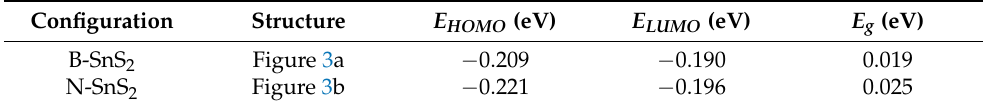
Figure 3. HOMO and LUMO of ( a ) B-SnS 2 and ( b ) N-SnS 2 . Table 1. Energy of HOMO, LUMO, and energy gap of B-SnS 2 and N-SnS 2 . Configuration